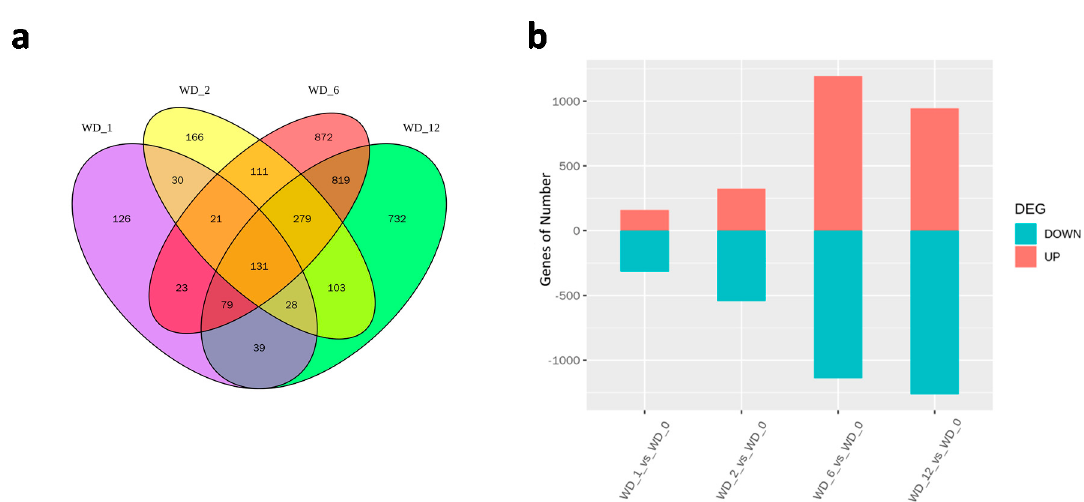
Figure 4. Analysis of differentially expressed genes in response to heat stress. ( a ) Venn diagram analysis of significantly differentially expressed genes at the four heat stress time points. ( b ) Numbers of significantly regulated genes at the four heat stress time points. Red and green columns represent the number of up- and down-regulated genes at different heat stress time points, respectively.